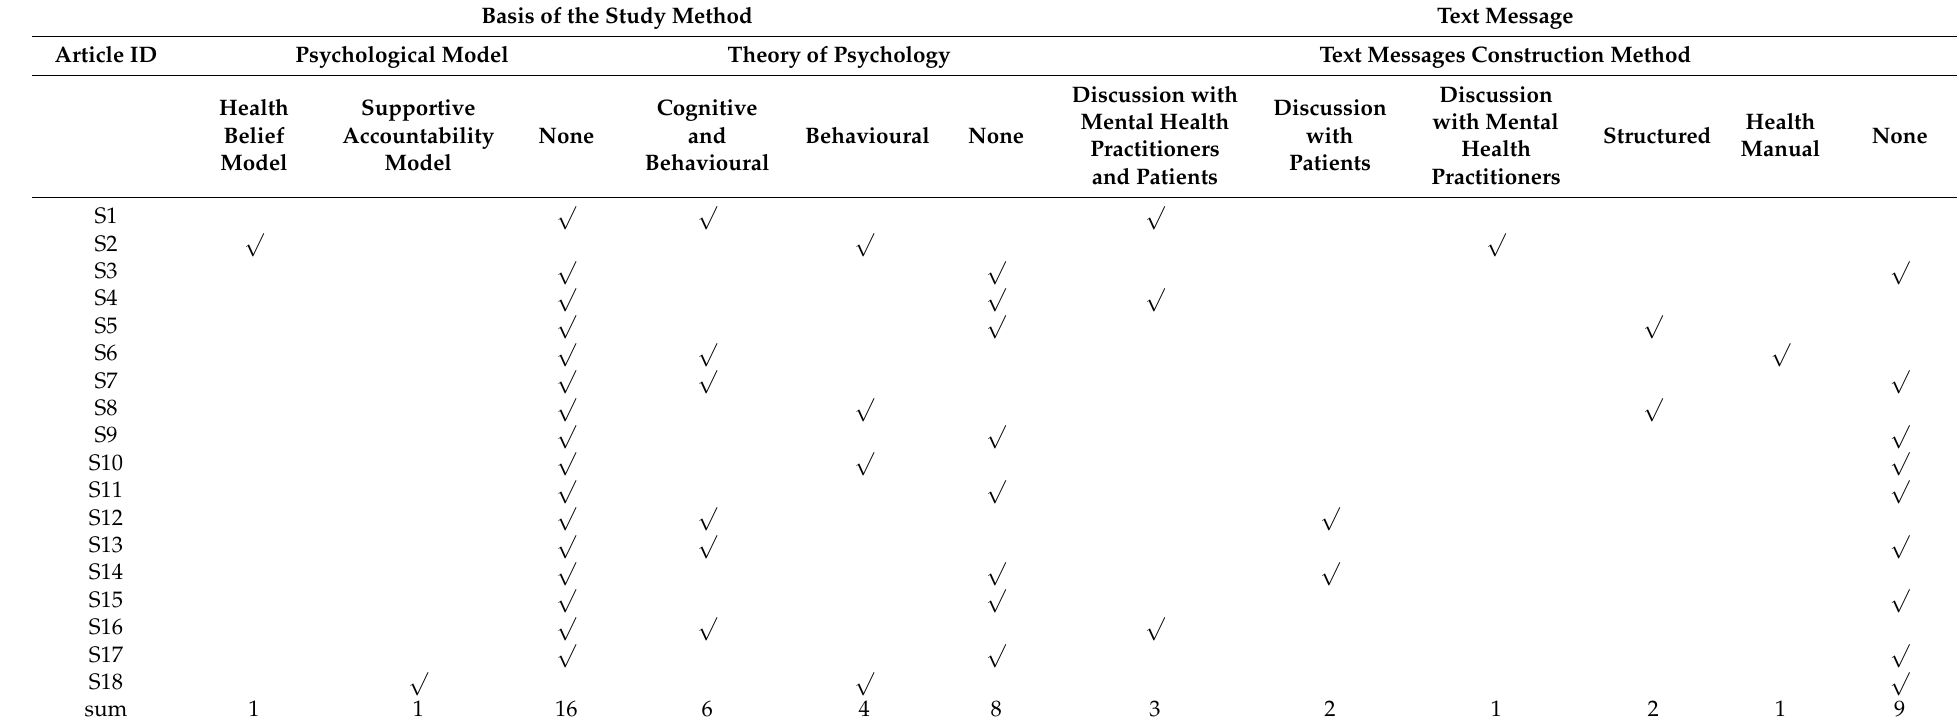
Table 2. Theory, Model and Text Message Construction Method as Reported in Selected